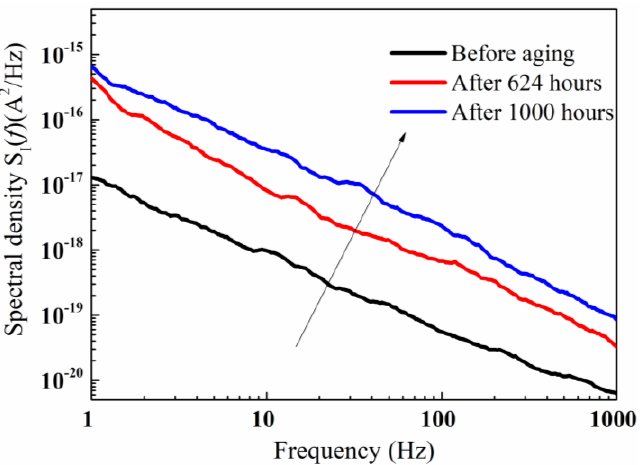
Figure 8. The current noise power spectral density curve versus frequency of the VCSEL, before and after aging.